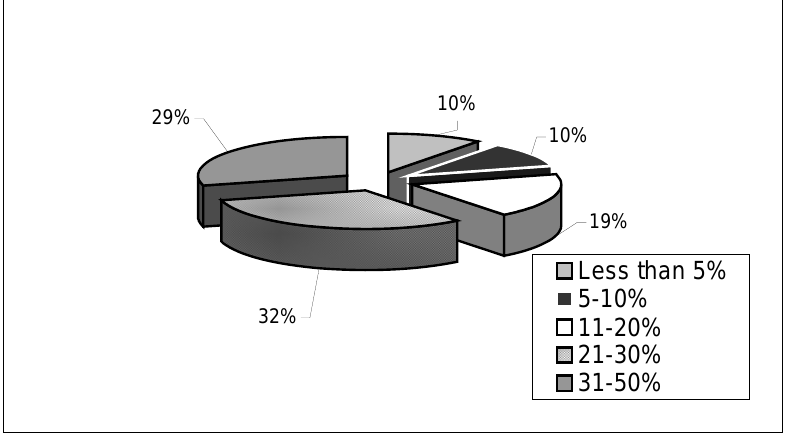
Figure 1. Percent of cervical exams provided to WHC patients compared to general patient population in Nevada WHC-participating clinics